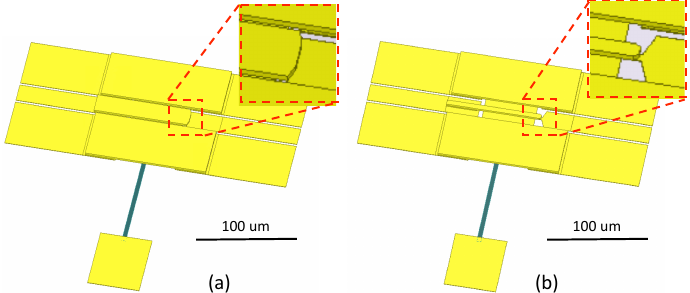
Figure 7. Three dimensional (3-D) model of fused quartz-based MEMS switch. In the initial design ( a ) the actuator has the same width as the CPW’s signal line, which causes roughly 2 fF parasitic capacitance at the tip. To reduce such capacitance, the actuator’s width was reduced and the tip is trimmed to further reduce the capacitance ( b